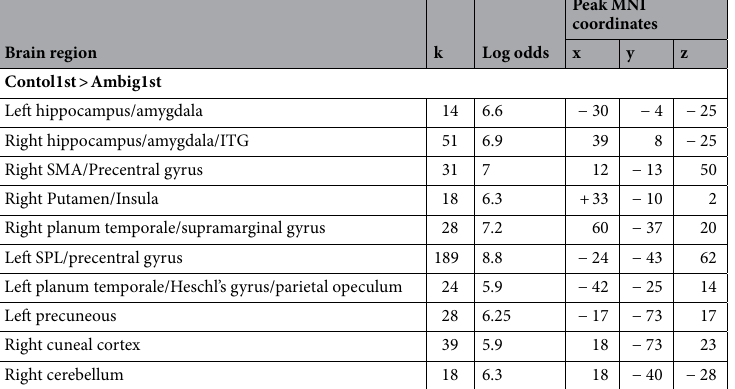
Table 1. Decreases in the BOLD signal associated with processing of a non-selected solution revealed in the Control1st > Ambig1st contrast. Denotations: L/R left/right hemisphere, k cluster size in voxels, ITG inferior temporal gyrus, SMA supplementary motor area, SPL superior parietal